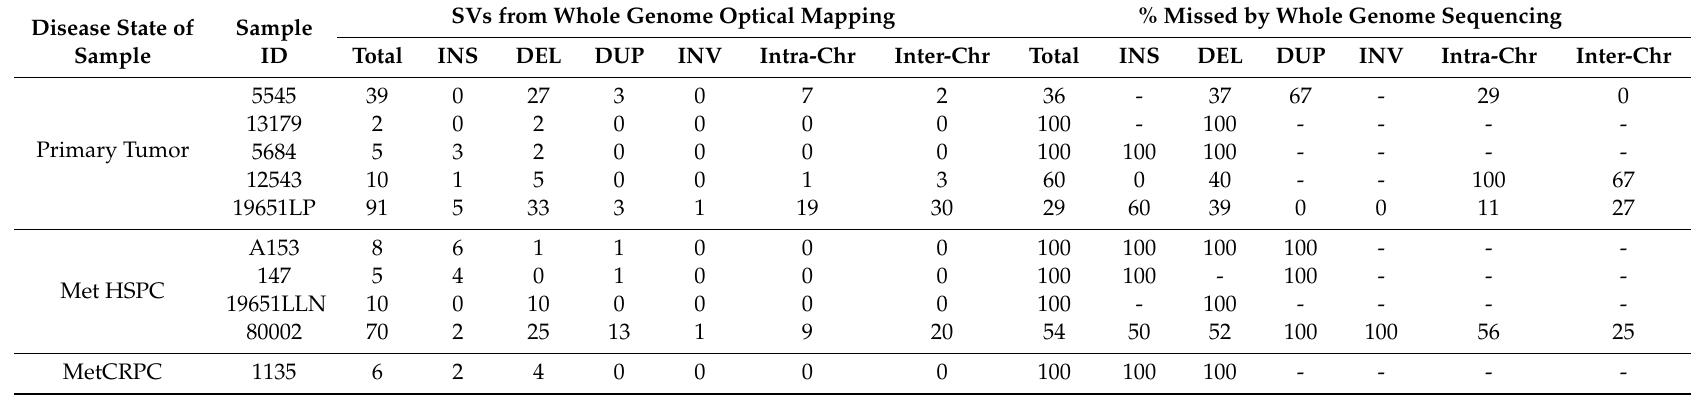
Table 3. Structural variants identified by optical mapping as compared to whole genome sequencing. INS: Insertion; DEL: deletion; DUP: duplication; INV: inversion; Intra-Chr: intrachromosomal translocation; Inter-Chr: interchromosomal translocation. Disease State